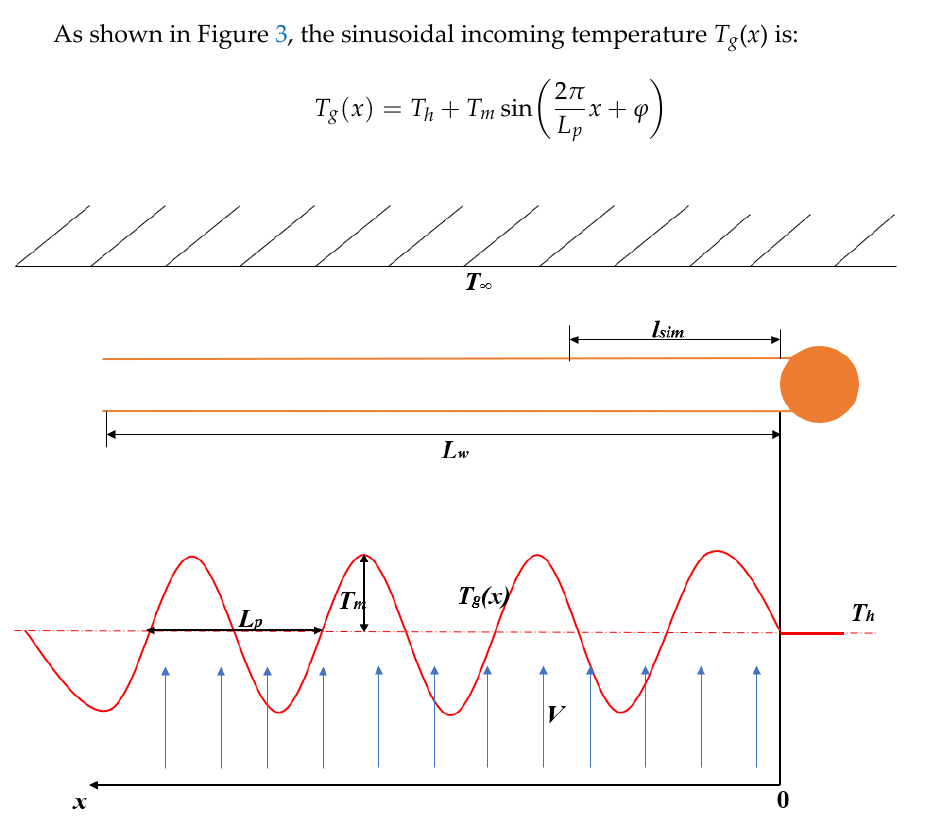
Figure 3. Schematic of sinusoidal incoming temperature profile.